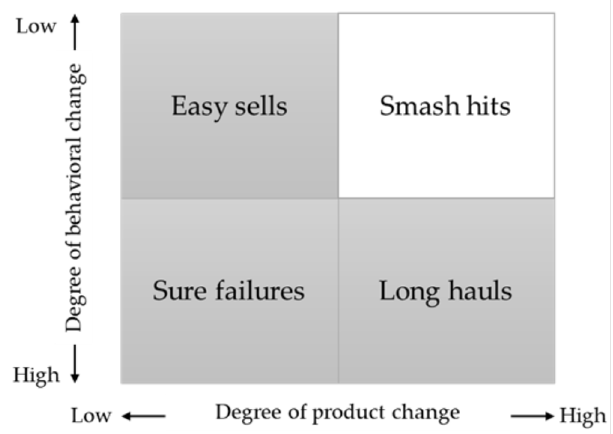
Figure 16. Behavioral tradeoff